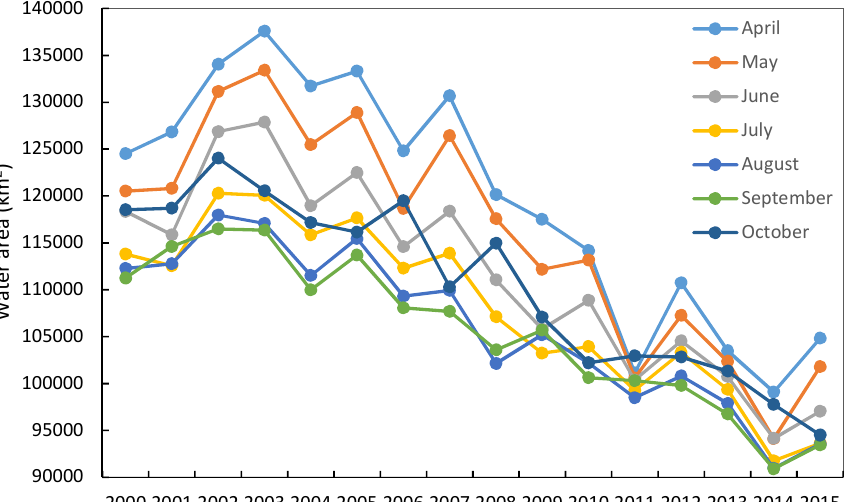
Figure 9. The changes in water area for each month across the year in the arid and semi-arid regions of central Asia. Table 3. The statistics of the change pattern for Figure 9.